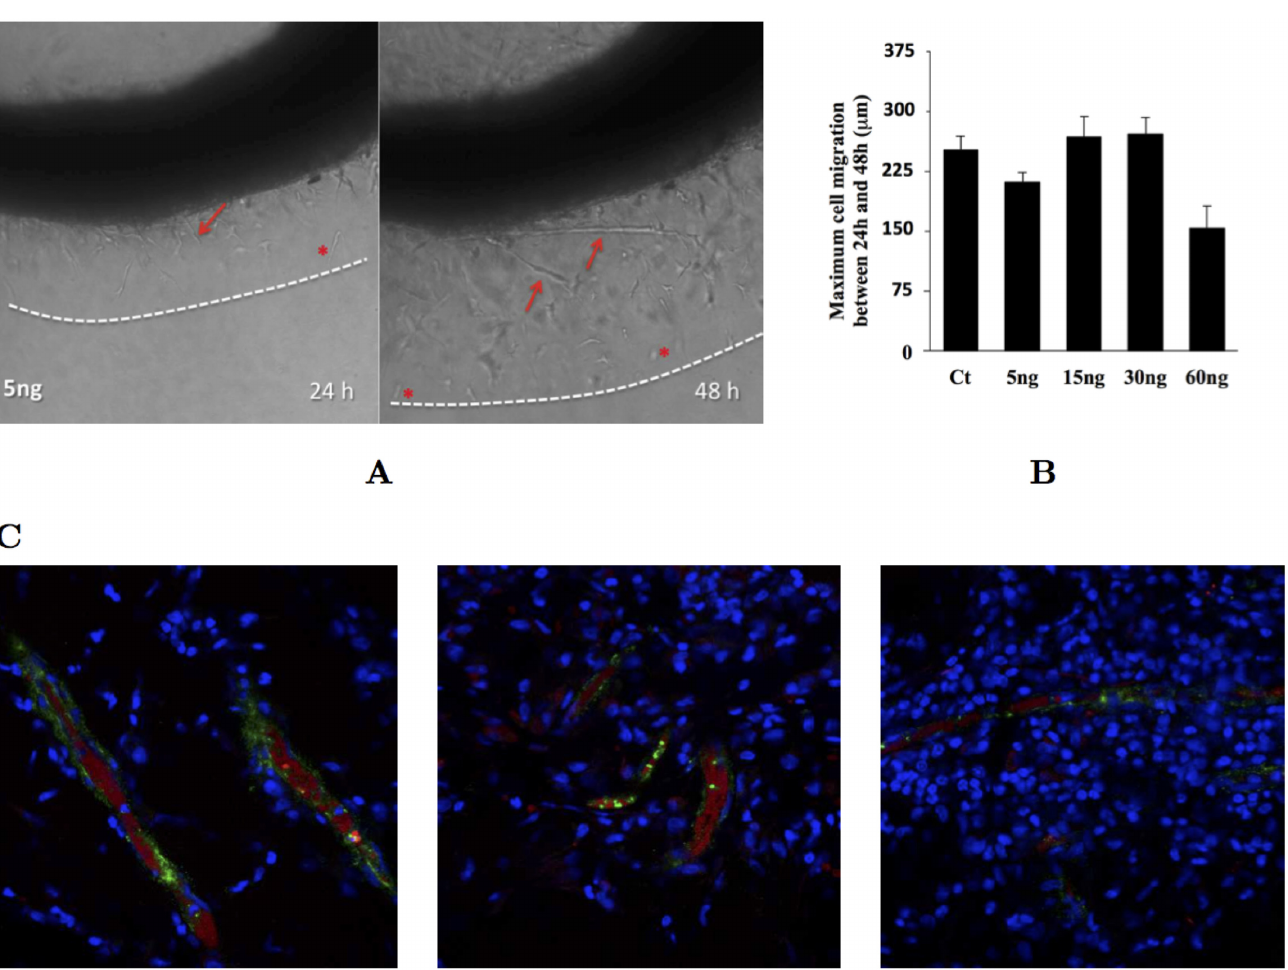
Fig 3. Examples of vessel sprouting ex vivo and in vivo . Plate A: Aortic ring assay. In this experiment a circular segment of a rat aorta is immersed in a collagen matrix (see sections five and six of the S1 Text for materials and methods related to these experiments). In the following days new sprouts (arrows) form and grow out the ring. Isolated endothelial cells (stars) also leave the vessel and migrate in the matrix. Plate B: Maximum distance travelled by an isolated endothelial cell for different values of the initial VEGF concentration in the medium. We observe that this distance is independent of the concentration of VEGF (except for very high concentrations, where the receptors are all overloaded). We use the velocity of these cells to parameterise the model (see section 4 of S1 Text) Plate C: Matriplug assay. In this system, 0.6 ml of Matrigel are injected in the back of a rat. During the next 7 days, endothelial cells invade the matrigel and blood starts flowing. After these 7 days the Matrigel was excised and observed using a confocal microscope. In these figures the cells nuclei are marked with DAPI (in blue), the perfused vessels are marked with Evans Blue (in red) and the endothelial cells are marked with anti-von Willebrand factor (in green). We observe several functional vessels, but not isolated endothelial